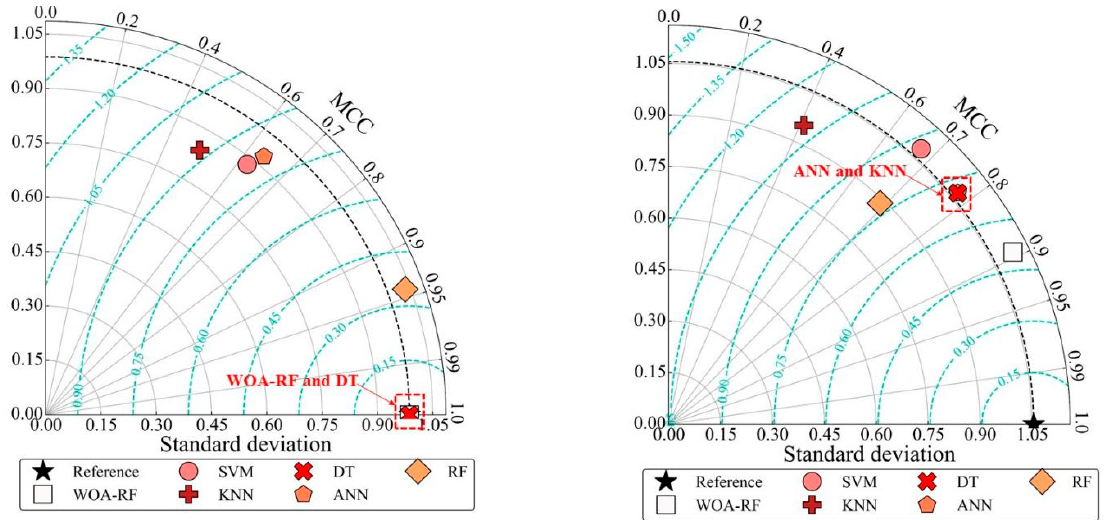
Figure 10. Taylor graph training datasets, b testing datasets.